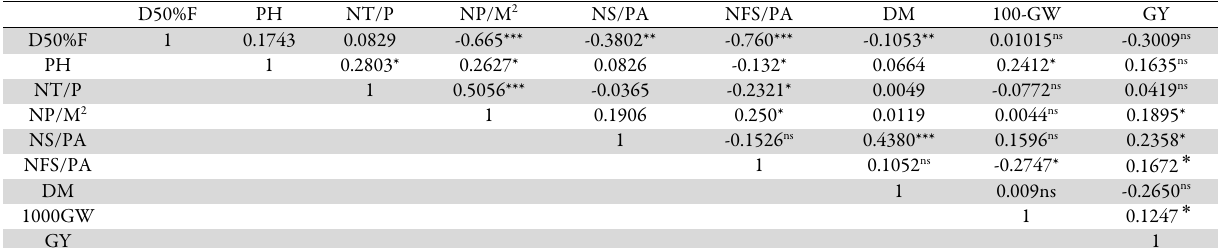
Table 6. Correlation coefficients of yield and other key agronomic traits of the 12 rice genotypes for the two years